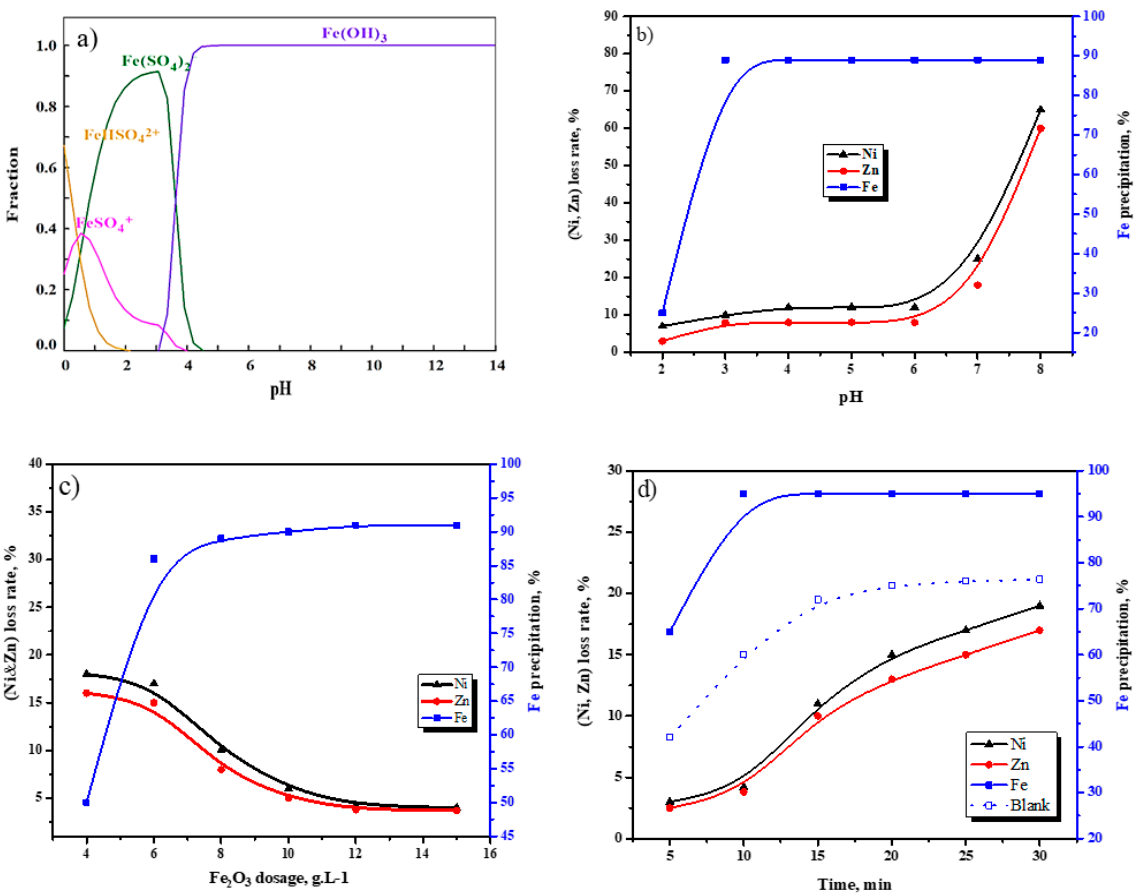
Figure 7. Species distribution diagrams of Fe-H 2 SO 4 systems ( a ) containing 0.235 mol/L of Fe and 1.56 mol/L of SO 42 − , Effect of pH value ( b ), Fe 2 O 3 added amount ( c ) and precipitation time ( d ) on Fe precipitation rate and Ni, Zn loss rates.